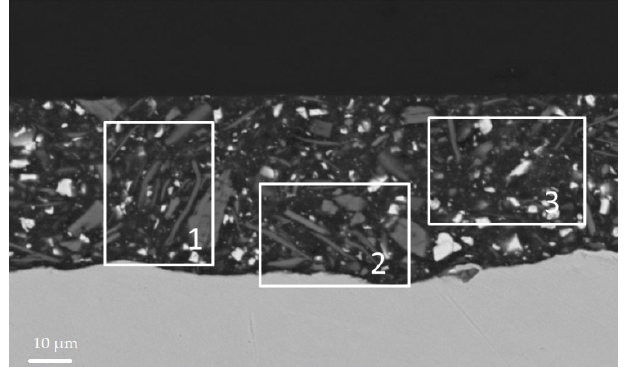
Figure 11. S4 coating; section before HT. In the squares: (1,2) densely packed wollastonite and (3) wollastonite free region.